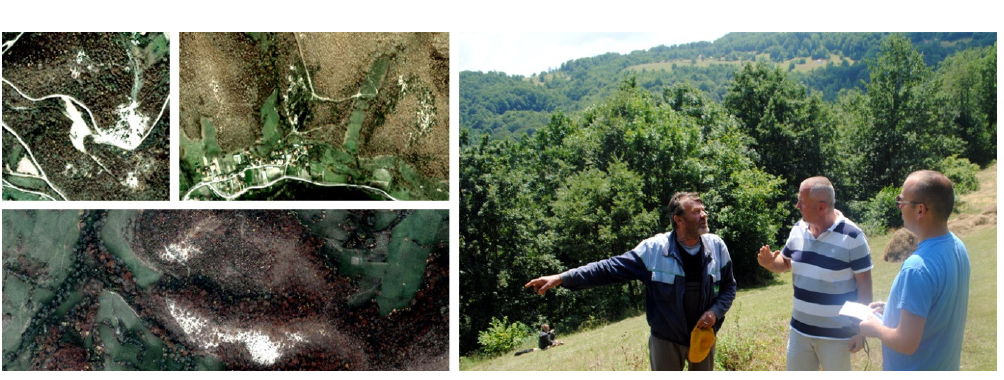
Figure 14. Collection on data on land use and on soil erosion processes from the field and using Google data; Kanje (43 ◦ 08 (cid:48) 22.0” N 19 ◦ 45 (cid:48) 40.9” E; 43.139430,